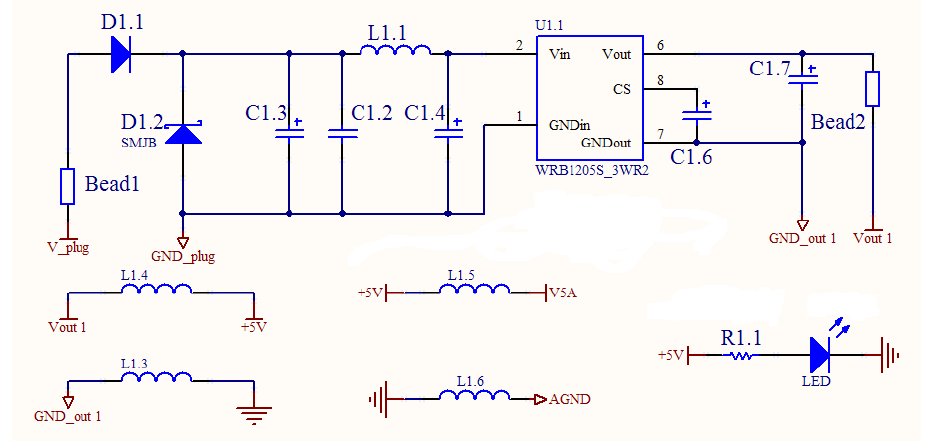
Figure 3. Power circuit